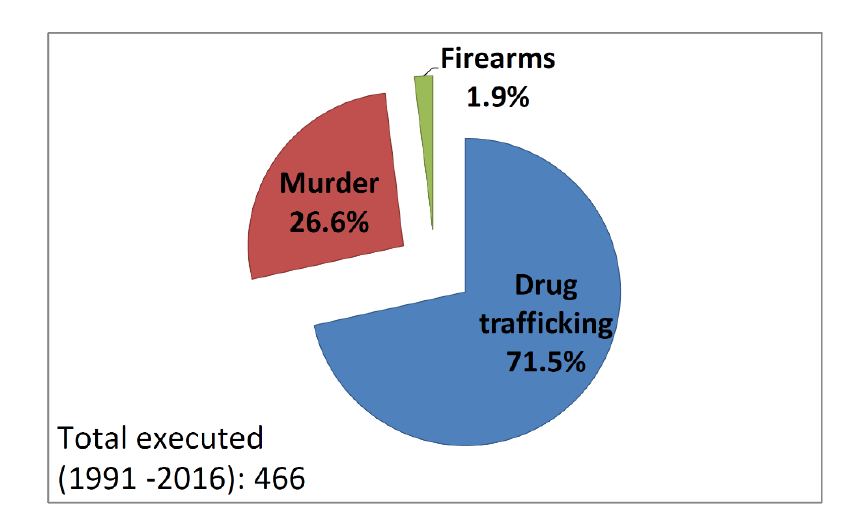
Figure 1: Breakdown of Executions 1991-2016 (Chan 2017)